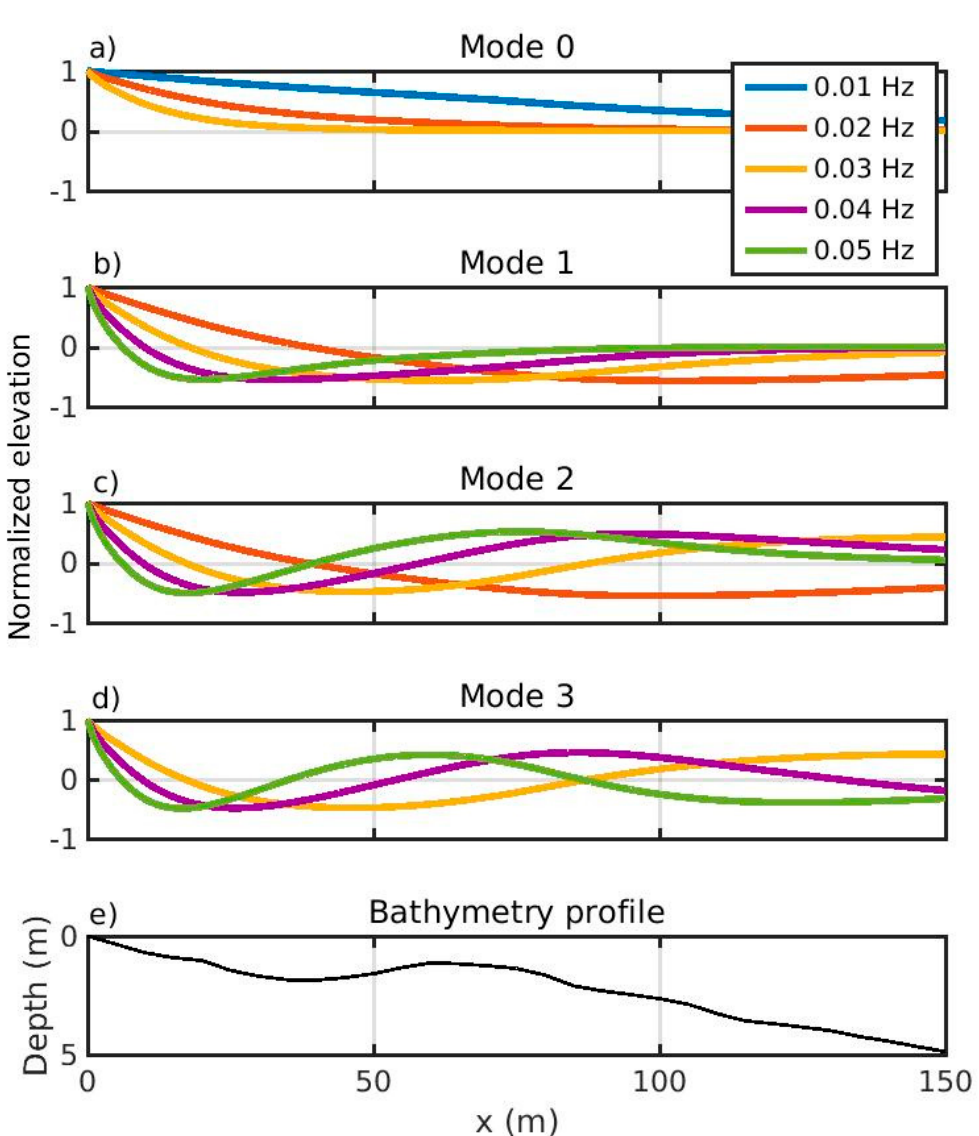
Figure 2. ( a ) to ( d ) Cross-shore profiles of elevation, with amplitude at the shoreline taken as unity, for the first four edge wave modes, for four edge wave frequencies, calculated based on the Secret Harbour bathymetry during the study period; e ) averaged cross-shore bathymetry profile measured at Secret Harbour.